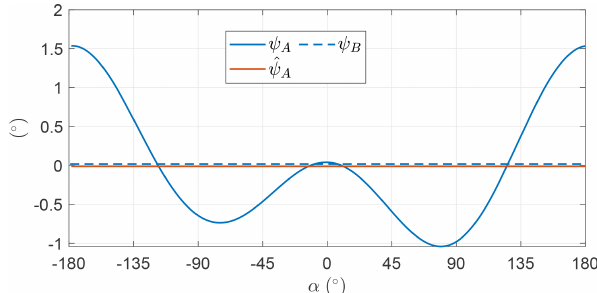
Figure 9. Optimal ψ as a function of the angular position.